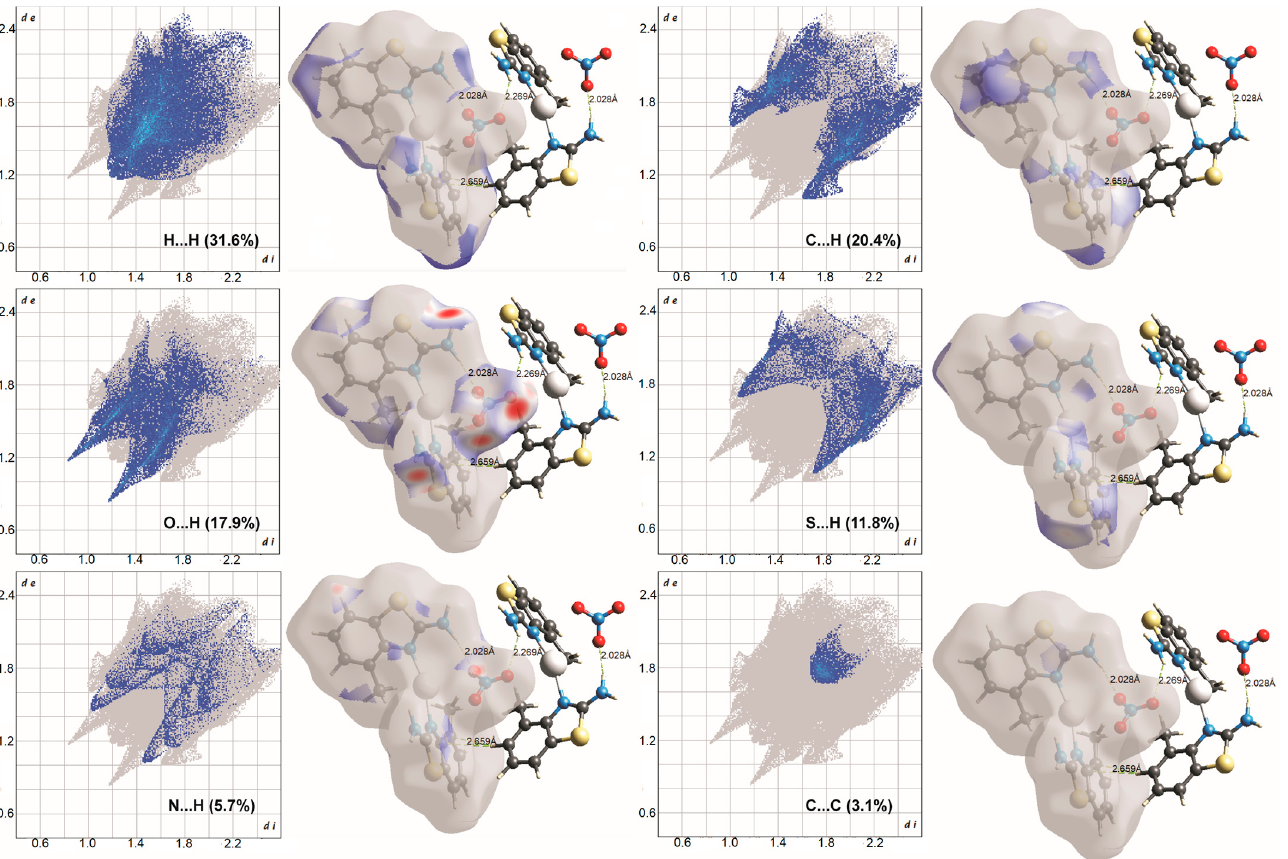
Figure 3. A 2D fi nger plots showing intermolecular interactions in complex 2 , percent contribution for each contact is speci fi